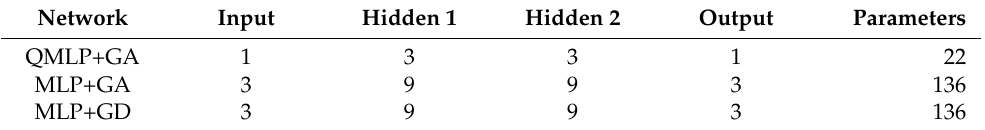
Table 1. Neural network topologies for the Ackley Function approximation.